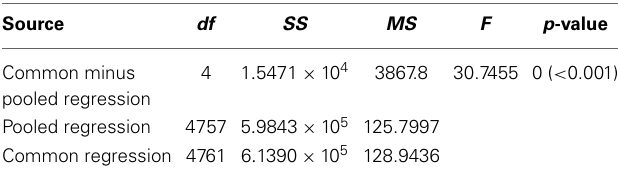
Table 3 | Summary of the results of the Tukey pairwise comparison tests.